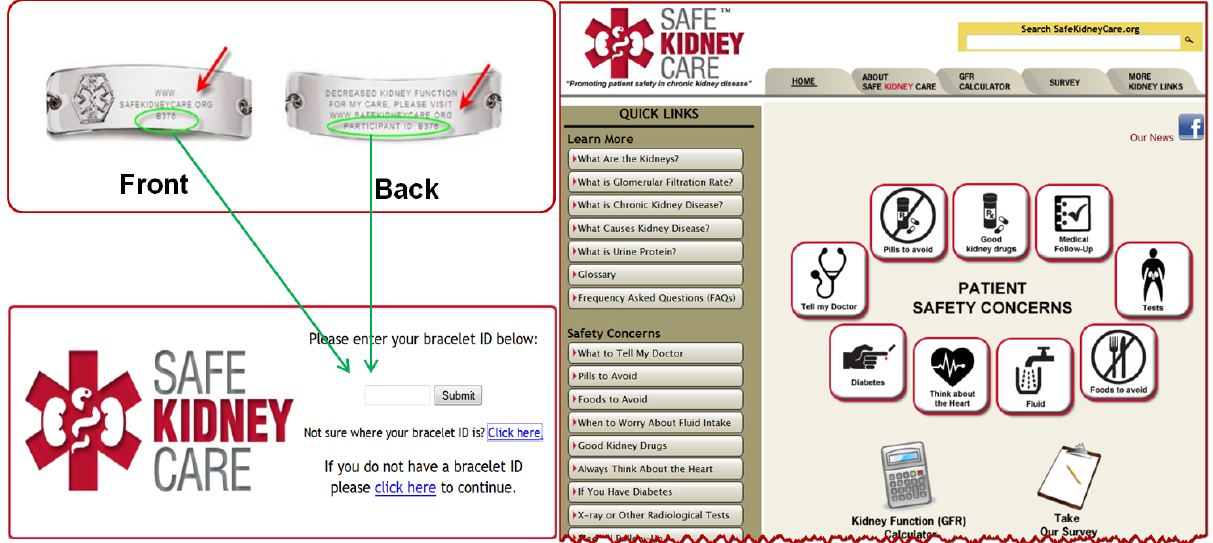
Figure 1. Medical alert accessory and log-in page of Safe Kidney Care website patient